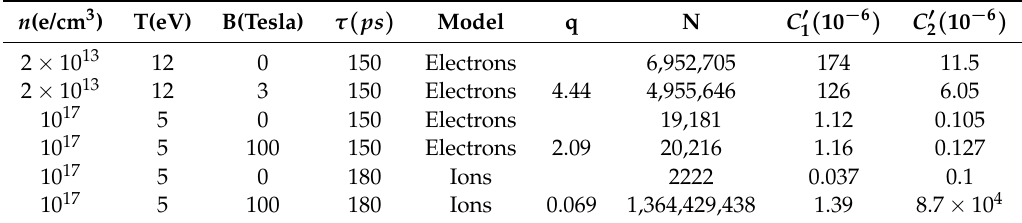
Table 1. Typical Number of perturbers